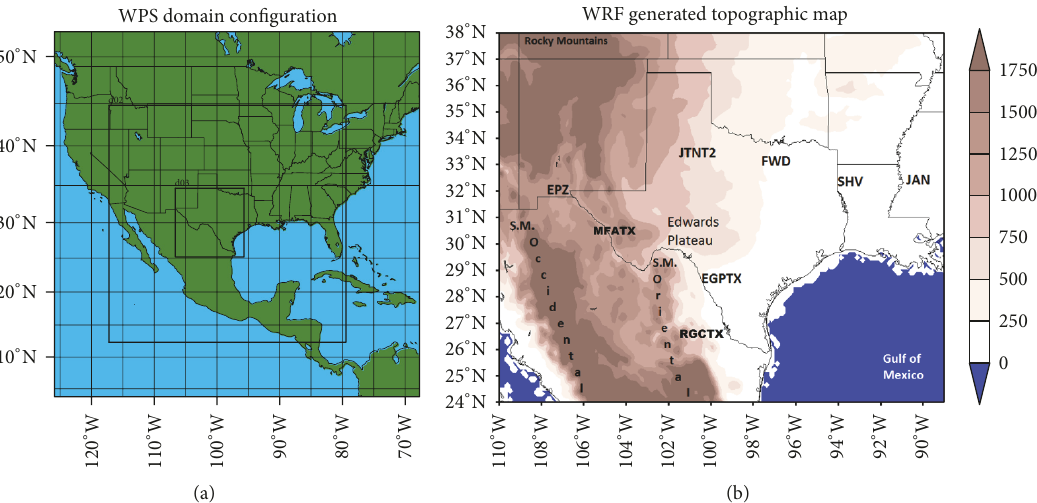
Figure 1: (a) Three nested WRF domain grid (36, 12, and 4km resolution) and (b) WRF generated topography (m) map from the 12km domain with geographical site locations over the area of interest included.